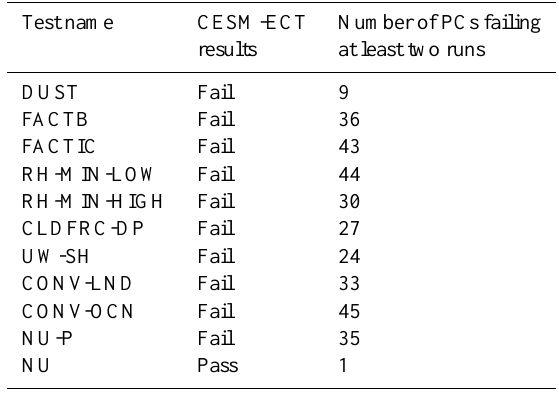
Table 1. CESM modifications expected to change the climate.